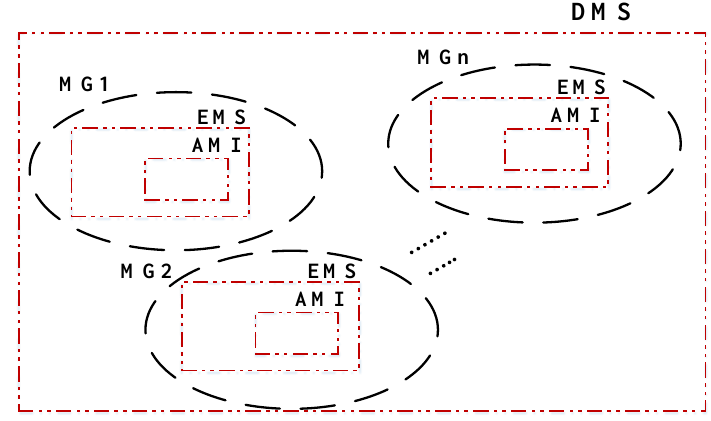
Figure 2. DMS supervisory level domain.